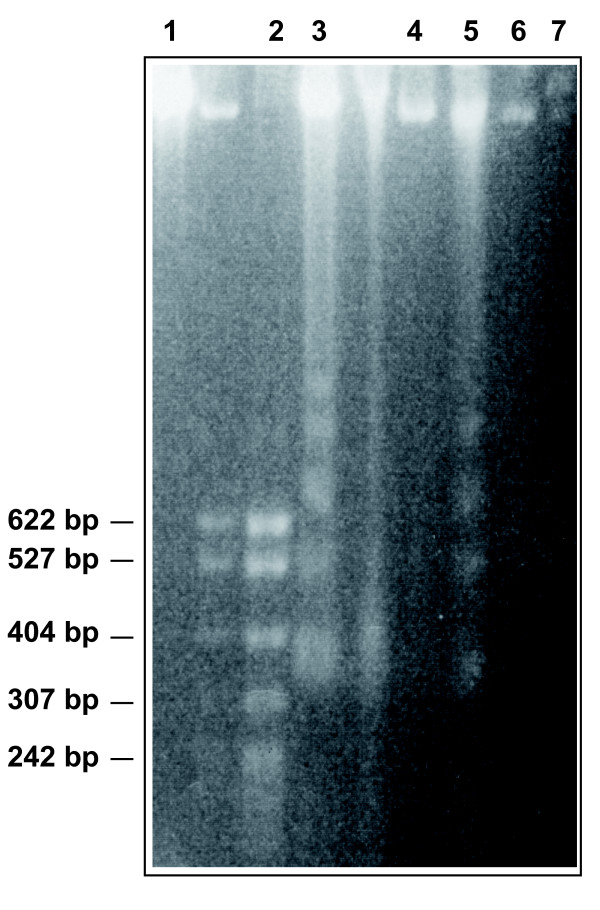
Internucleosomal DNA fragmentation induced by GCV. Lane 1 and lane 4 show DHDK12 cells and HT29 cells transduced with TG 9344 and treated for 96 hr with 20 μM GCV, respectively. Lane 3 and 5 show DHDK12 cells and HT29 cells transduced with TG 9344 after a 24 hr pretreatment with MTX and treated for 96 hr with 20 μM GCV, respectively. Lane 6 and 7 show DHDK12 cells and HT29 cells treated for 24 h with MTX, respectively. Lane 2 shows pBR 322 base pair size markers. Qualitative detection of DNA was achieved by ethidium bromide staining.